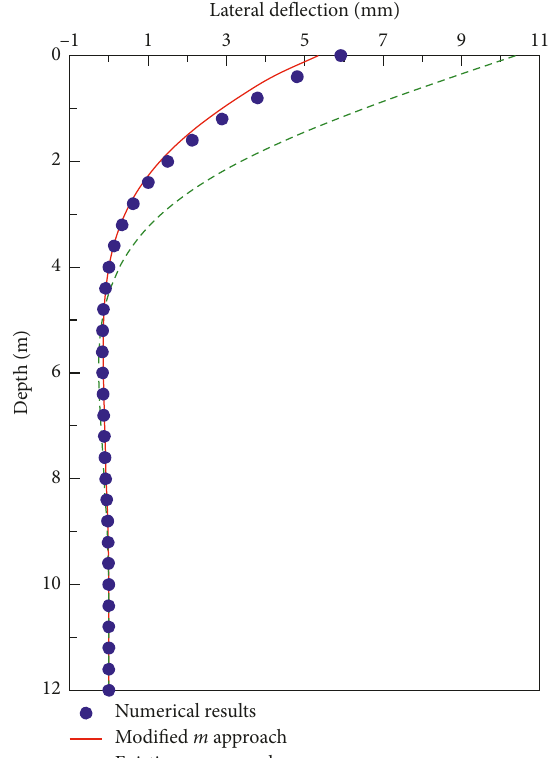
Figure 10: Comparison of predicted pile deflections from the modified and existing m approach and numerical results at a lateral load of 100kN.